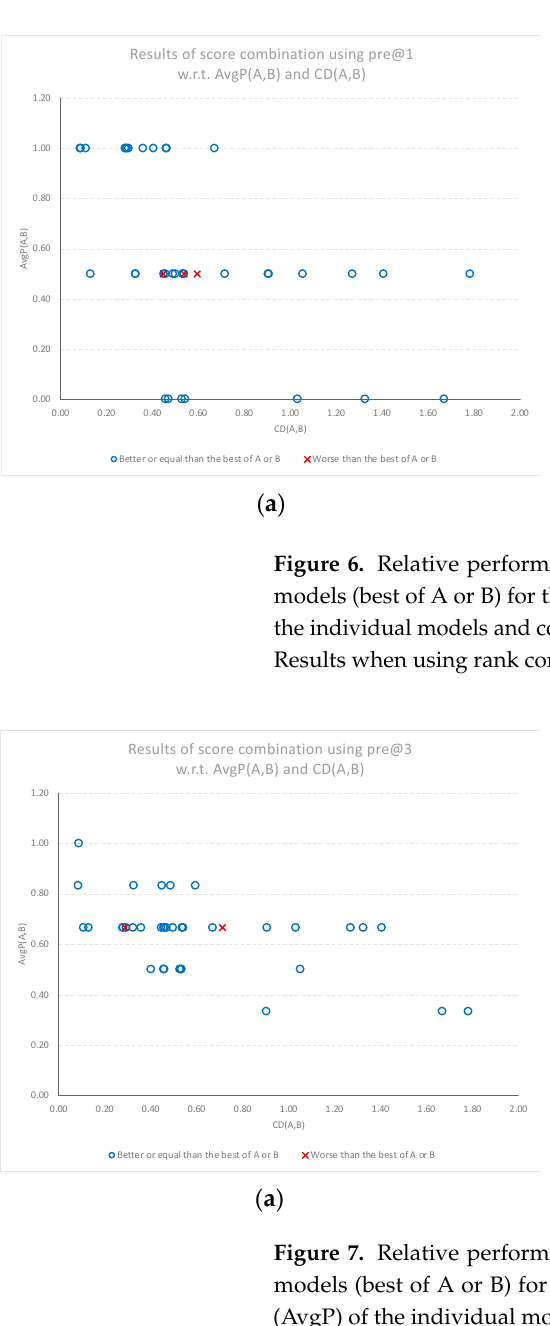
Figure 7. Relative performance of the combined models compared to the best of the individual mod- els (best of A or B) for the top three classifications, plotted against the average performance (AvgP) of the individual models and cognitive diversity. ( a ) Results when using score combination SC ( A , B ). ( b ) Results when using rank combination RC ( A , B ).